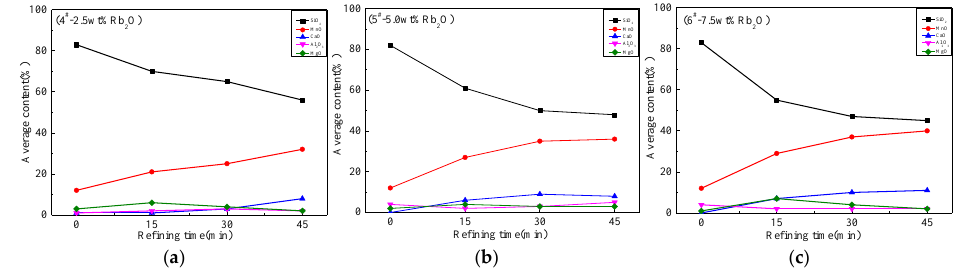
Figure 8. Average content of each component in inclusions during refining. ( a ) 4 # , 2.5 wt% Rb 2 O; ( b ) 5 # , 5 wt% Rb 2 O; ( c ) 6 # , 7.5 wt% Rb 2 O.